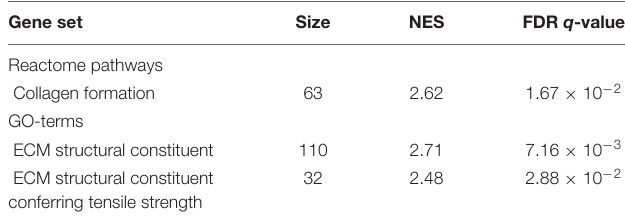
TABLE 3 | Gene set enrichment analyses (GSEA) of association results for protein-damaging SNPs.